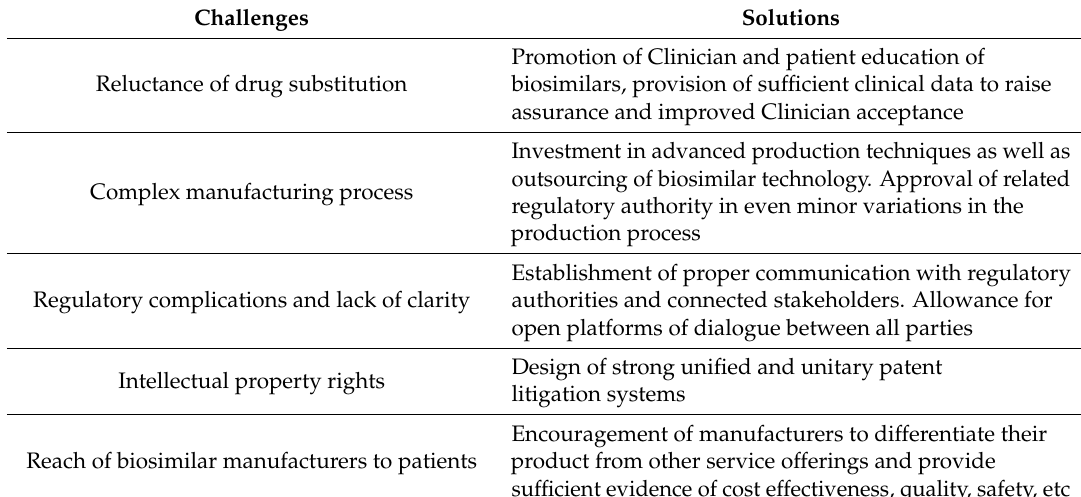
Table A2. Current Challenges to Biosimilar Introduction and their Potential